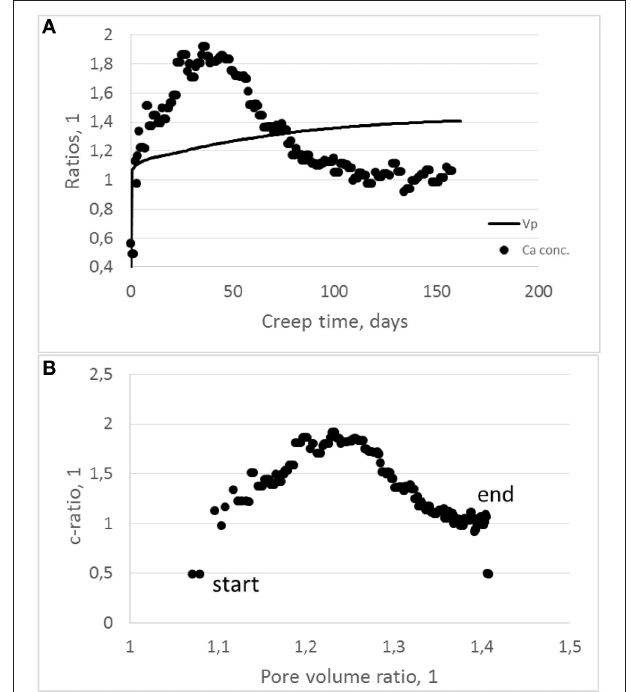
FIGURE 10 | (A) The pore volume ratio for the 0.5 divided by the 12.3 MPa development (solid line) plotted together with the calcium concentrations ratios for the same experiments (dots) as function of test time. (B) Displaying the correlation between the ratio of the effluent Ca-concentration divided by the pore volume ratio. As can be seen, a positive correlation is seen the first 30 (or so) days. The peak concentration ratio occurs after 30–40 days, before a negative trend is